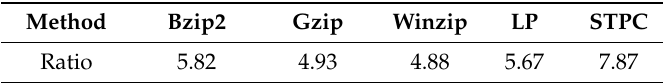
Table 4. Compression ratio of different